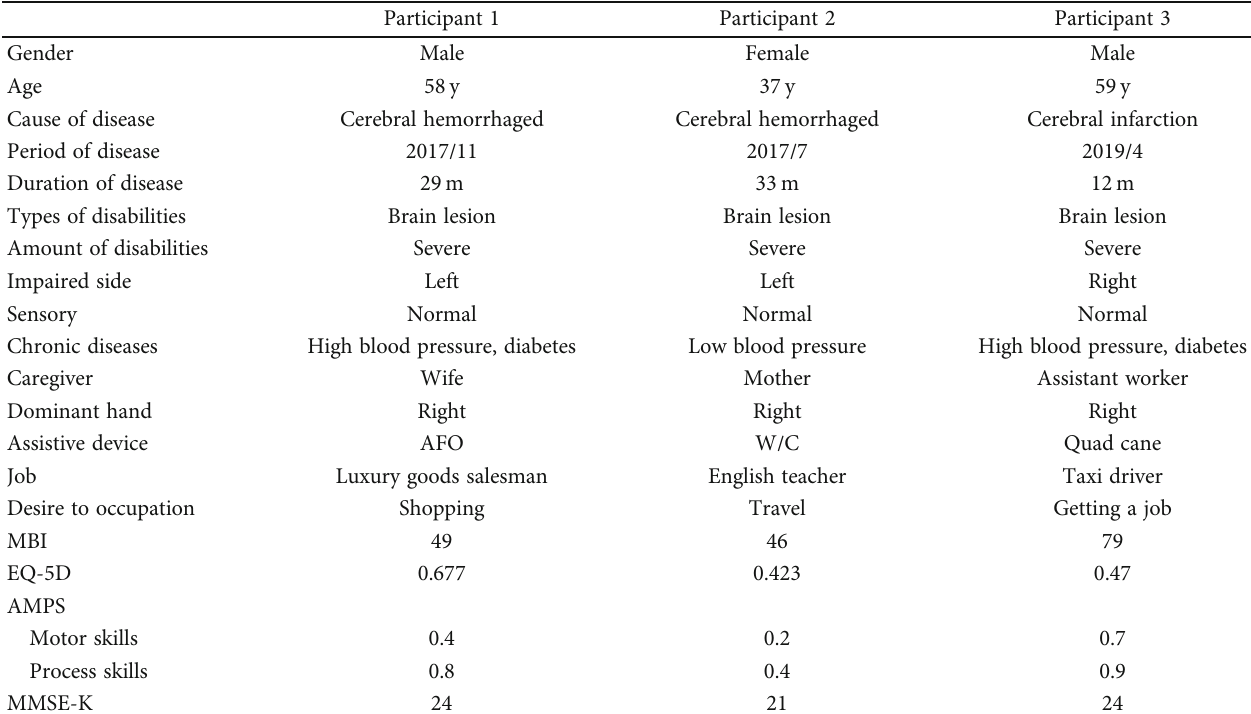
Table 2: General characteristics of the